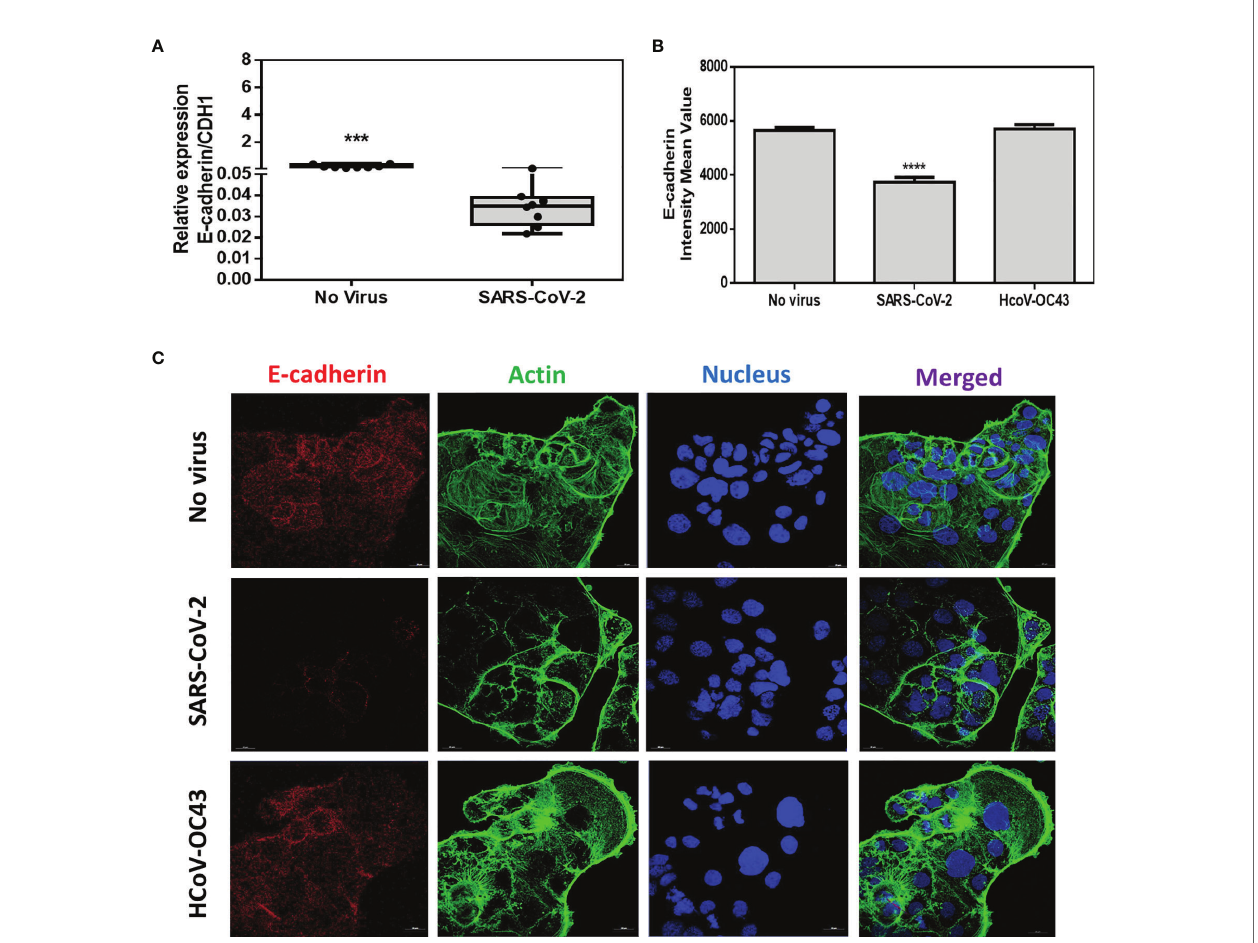
FIGURE 5 | Expression of CDH1/E-cad mRNA and E-cad protein. (A) Expression of CDH1/E-cad mRNA in virus-free Caco-2 cells or cells exposed to SARS-CoV-2 at an MOI of 0.5 for 24 hours. The results (n=8) are expressed as RE where RE = 2 ( − D CT) .The symbol *** means a p-value < 0.001. (B) Quantitative representation of mean fl uorescence intensity (n=4) corresponding to E-cad protein expression on Caco-2 cells infected or not with SARS-CoV-2 or HCoV-OC43. The symbol the symbol ****means a p-value < 0.0001. (C) Illustration of single plane confocal microscope analysis of E-cad expression on subcon fl uent virus-free Caco-2 cells or cells exposed to coronaviruses SARS-CoV-2 or HCoV-43 at an MOI of 0.5 for 24 hours. The analysis was performed on cells permeabilized with 0.1% Triton X-100. Actin expression was shown as control as well as the labeling of the